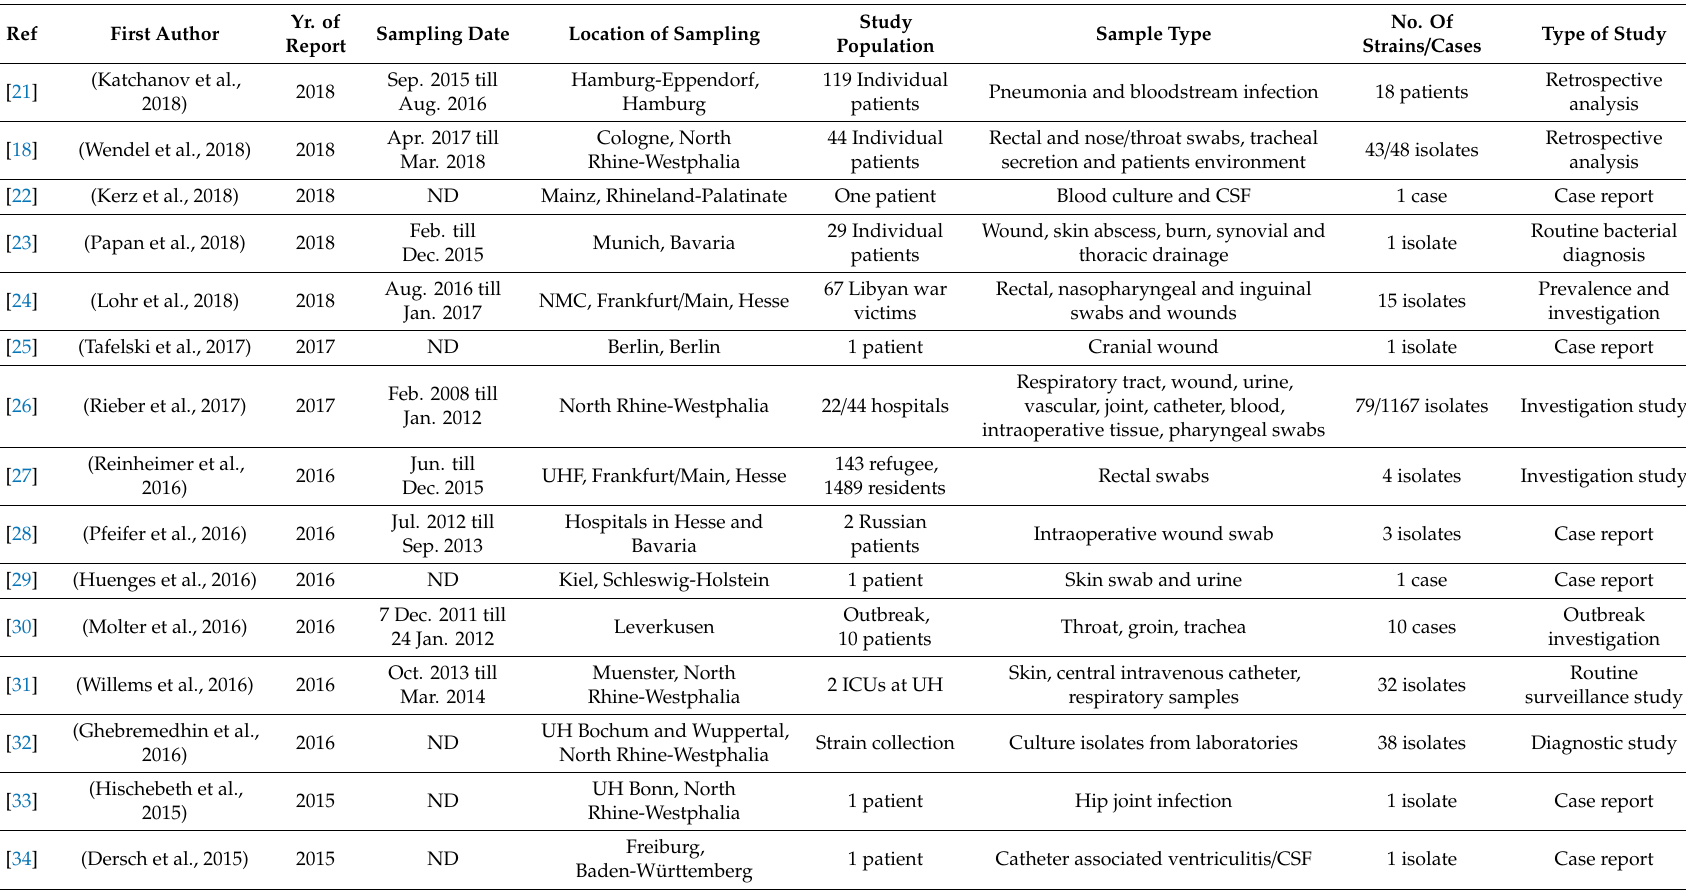
Table 1. Spatio-temporal distribution of studies on A. baumannii of human origin in Germany from 2000 to